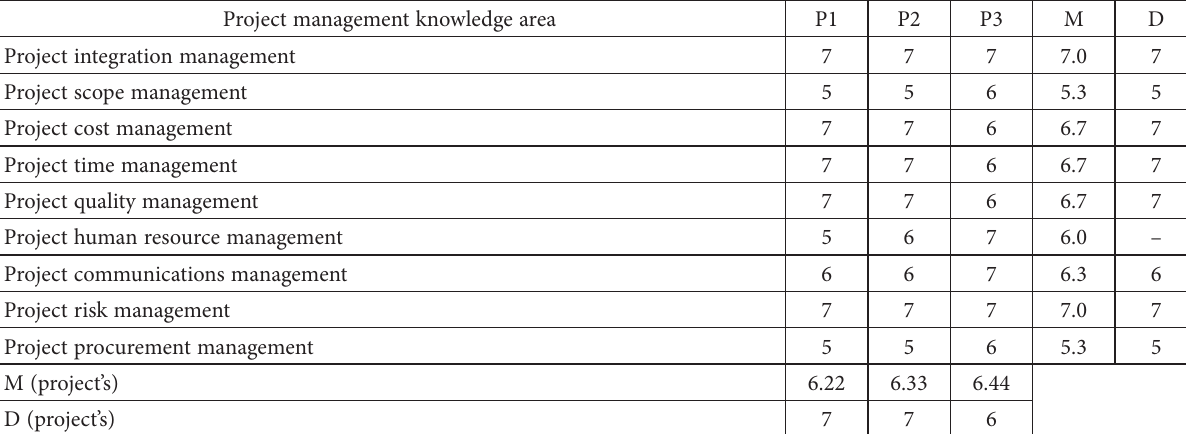
Table 7. Results of early warning system implementation attached to usefulness of the system’s help in project management